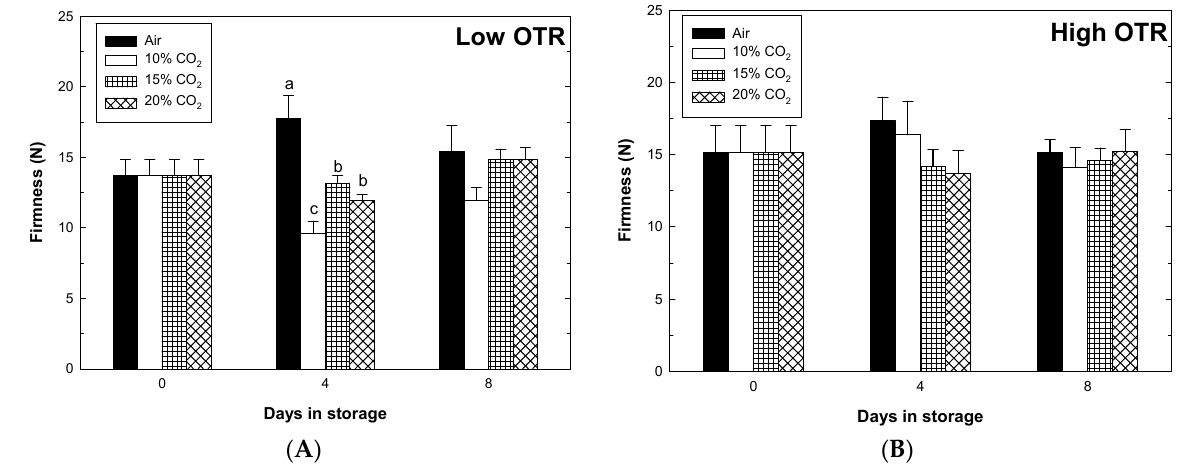
Figure 7. Firmness of ‘Pione’ grapes stored in active MAP of high CO 2 (10%, 15%, and 20%) with low-OTR films ( A ) and high-OTR films ( B ) at 10 °C for 8 days. Vertical lines represent the standard error of the mean ( n =9). Bars with different letters indicate significance at p ≤ 0.05 among treatments within the same day.